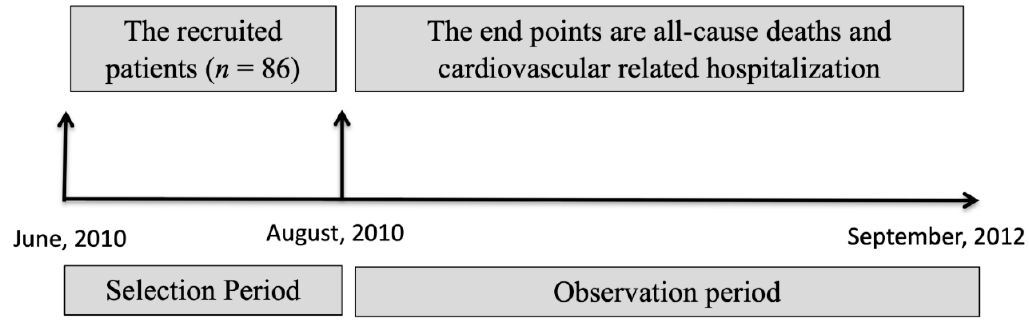
Figure 1. Study Figure 1. Study design.